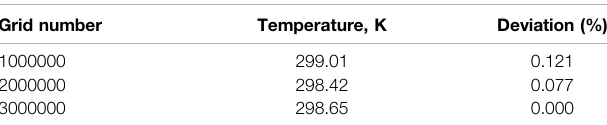
TABLE 3 | Grid independence